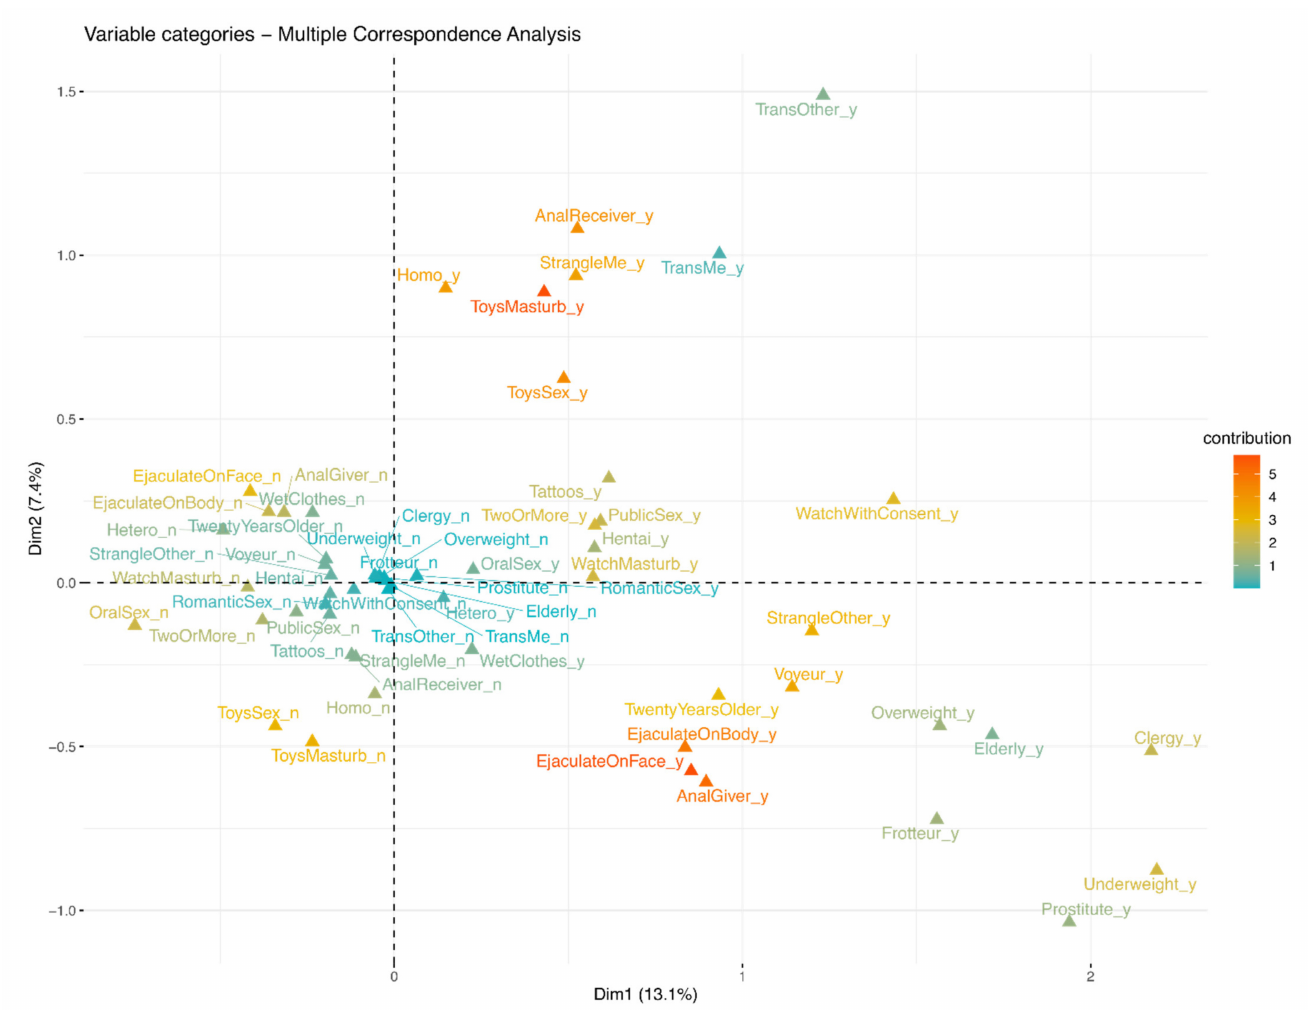
Figure 2. Contribution of positive and negative responses to the Multiple Correspondence Analysis principal dimensions. The names of the items correspond to those indicated in Table 1. Items ending with “y” correspond to positive answers while items ending with “n” correspond to negative answers. Warmer colours indicate stronger contribution of those items to each of the two dimensions represented on the cartesian